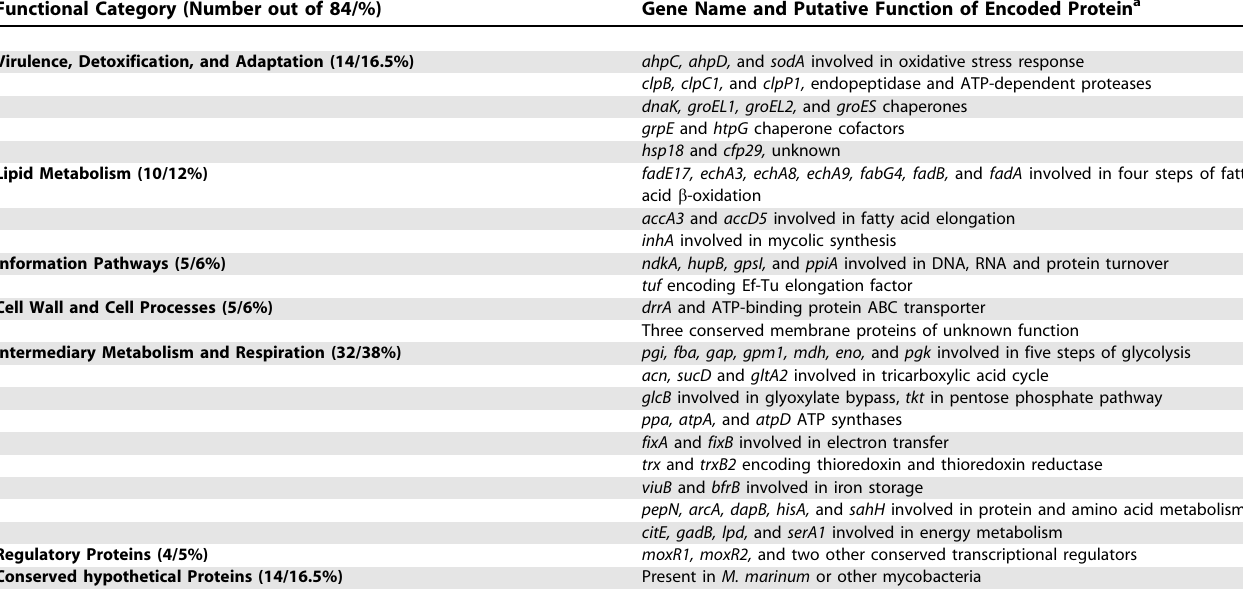
Table 1. Functional Classification of Proteins Localized in the ECM of M. ulcerans Functional Category (Number out of 84/%) Gene Name and Putative Function of Encoded Protein a Virulence, Detoxification, and Adaptation (14/16.5%)